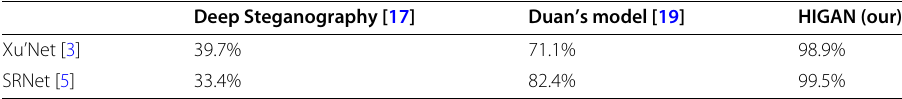
Table 3 The detection accuracy of steganalysis model